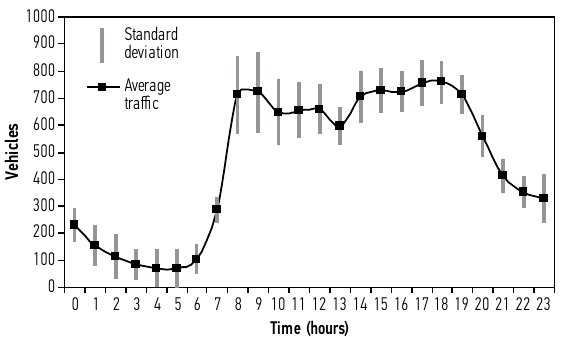
Fig. 5. An example of temporal variation of the passenger car flows obtained from the automatic counting data at a fixed point